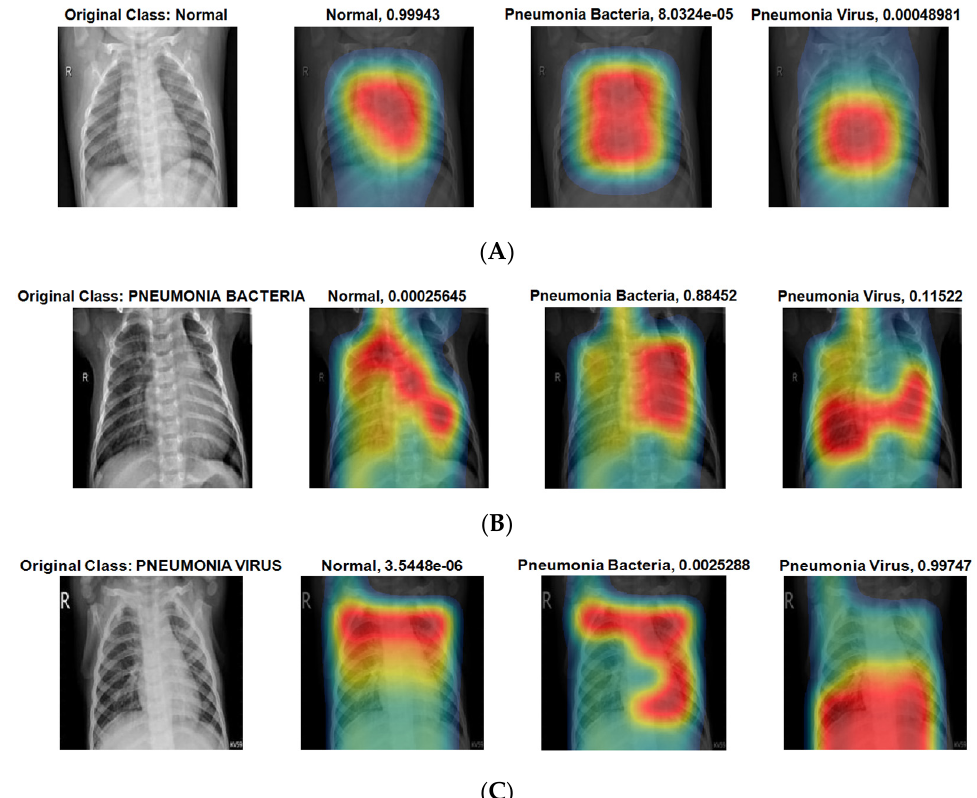
Figure 8. Class Activation Mapping (CAM); ( A ) Normal, ( B ) Bacterial Pneumonia, and ( C ) Viral Pneumonia.